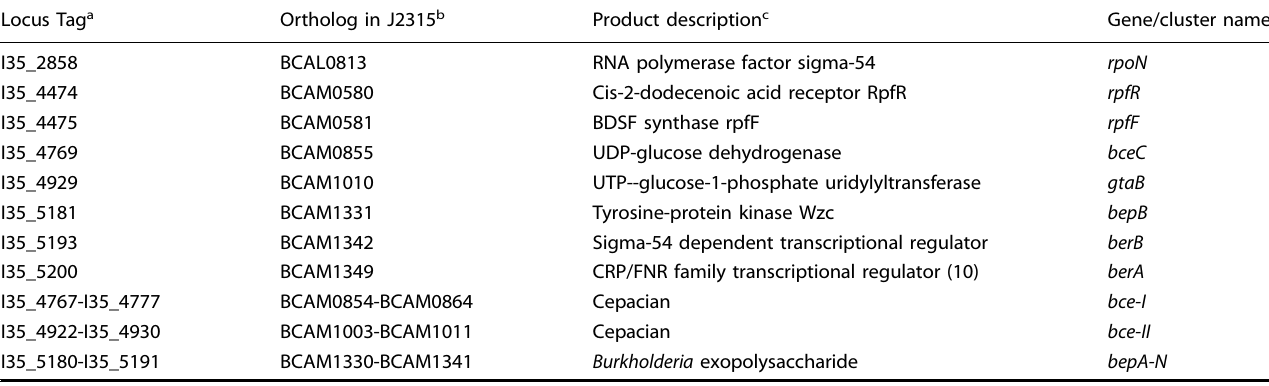
Table 2. Mutants constructed in this study. Locus Tag a Ortholog in J2315